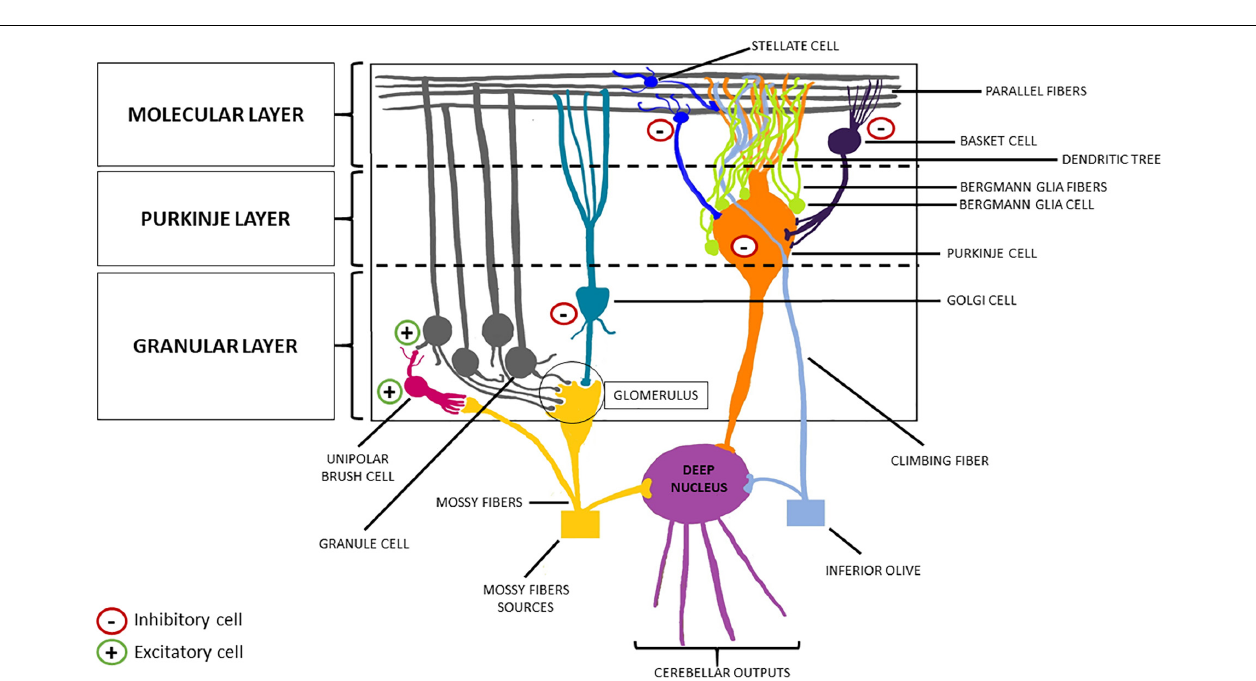
FIGURE 3 | Schematic representation of the cerebellar cortex. From the innermost part to the outermost one, the cerebellar cortex can be divided into three layers: the granular layer, the Purkinje layer, and the molecular layer. The former welcomes the granule cells (excitatory neurons) and the Golgi cells (inhibitory interneurons). The descending dendrites of these two cellular types together with the ascending mossy fibers (originating from the brainstem nuclei, the spinal cord and the reticular formation) make synapsis in this area, forming the so-called “glomerulus”. Purkinje cells (inhibitory neurons) are located in the middle layer, from which they send their axon to the deep nuclei, crossing the granular layer, and their dendrites to the molecular layer, forming a “dendritic tree.” Finally, basket cells and stellate cells are the two inhibitory interneurons of the molecular layer, making synapsis with the parallel fibers (originating from the T-split of the ascending axons of the granule